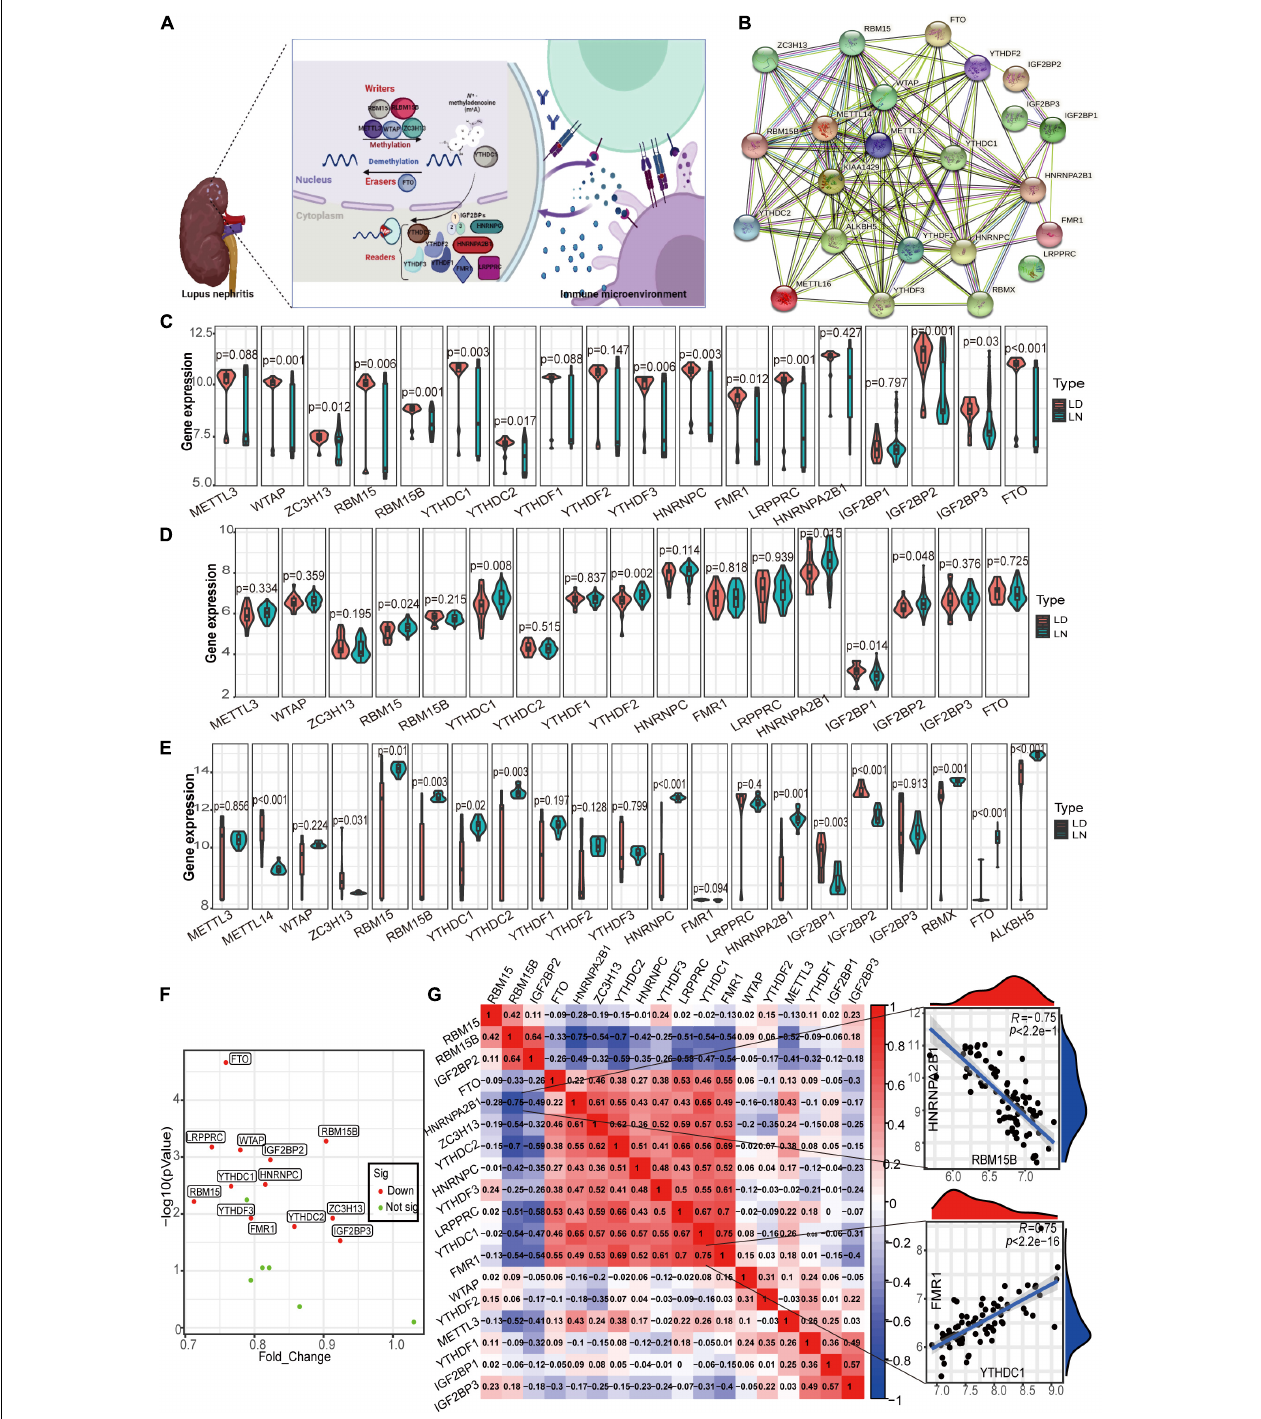
FIGURE 2 | Landscape of m 6 A RNA methylation regulators in LN. (A) m 6 A RNA methylation modification regulated by m 6 A “writer,” “reader,” and “eraser,” which is involved in the immune microenvironment of LN. (B) Protein-protein interaction (PPI) network composed of 23 m 6 A regulators. (C) Violin plot demonstrating the expression level of 18 m 6 A regulators in glomeruli between living donor and LN. (D) Violin plot demonstrating the expression level of 17 m 6 A regulators in tubulointerstitium between living donor and LN. (E) Violin plot demonstrating the expression level of 21 m 6 A regulators in kidney whole tissue between living donor and of LN. (F) Volcano plot showing a summary of the expression differences of 18 m 6 A regulators between the healthy and LN patients’ glomerular samples. (G) Correlations between 18 m 6 A regulators in LN glomeruli samples. The two respective scatterplots show the two pairs of m 6 A regulators with the highest correlation, HNRNPA2B1 and RBM15B with the most negative correlation, and YTHDC1 and FMR1 with the most positive correlation.